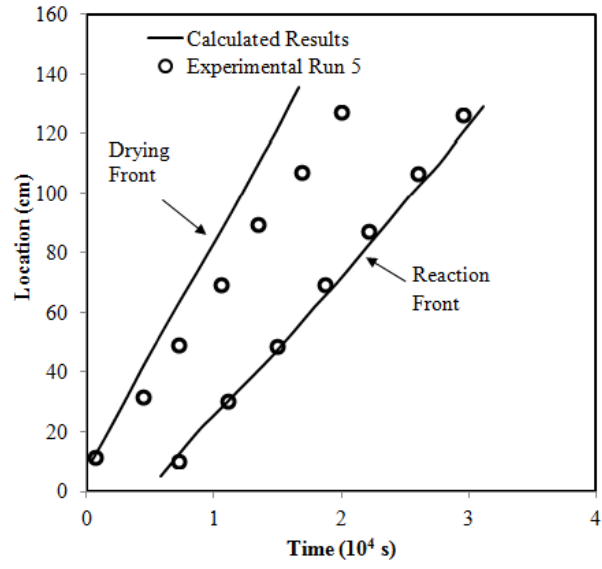
Figure 6. Comparison of calculated and experimental reaction and drying front movements [48].